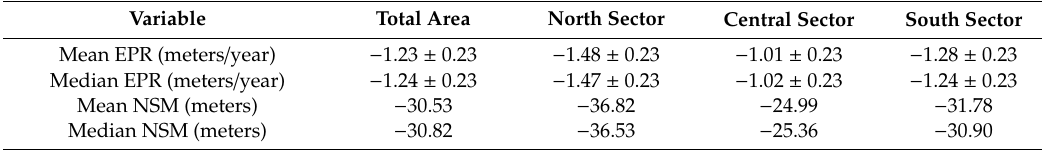
Table 3. Evolution rates between 1956 and 1981.